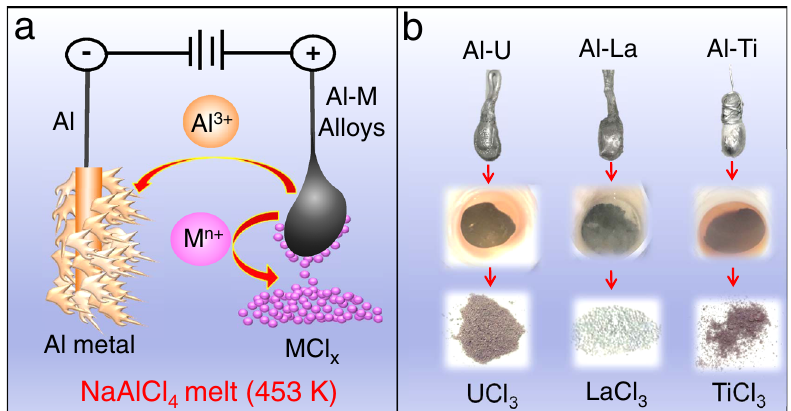
Fig. 1 Schematic of the IAP process. a Schematic illustration of the IAP process in NaAlCl 4 molten salt electrolyte. b Various alloys and corresponding metal chlorides precipitated in the bottom of crucible by electrolysis with different anodes and fi nal metal chloride products